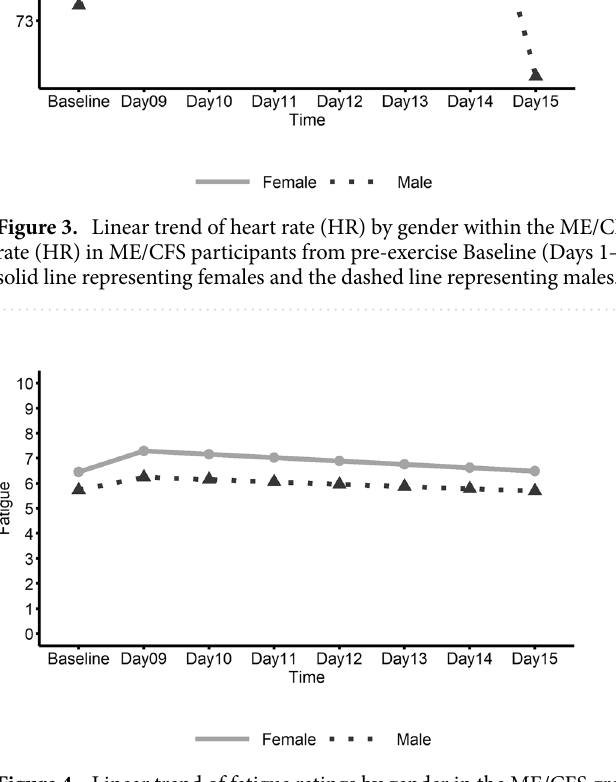
Figure 4. Linear trend of fatigue ratings by gender in the ME/CFS group. This graph shows daily fatigue ratings in ME/CFS participants from pre-exercise Baseline (Days 1–8) to follow-up (Days 9–15) with the solid line representing females and the dashed line representing